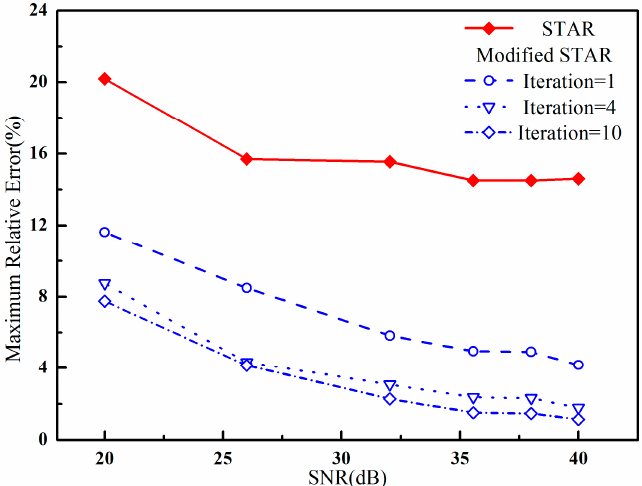
Figure 5. The maximum relative error between the estimated parameters and the true values versus SNR using synthetic data with additive Gaussian noise.